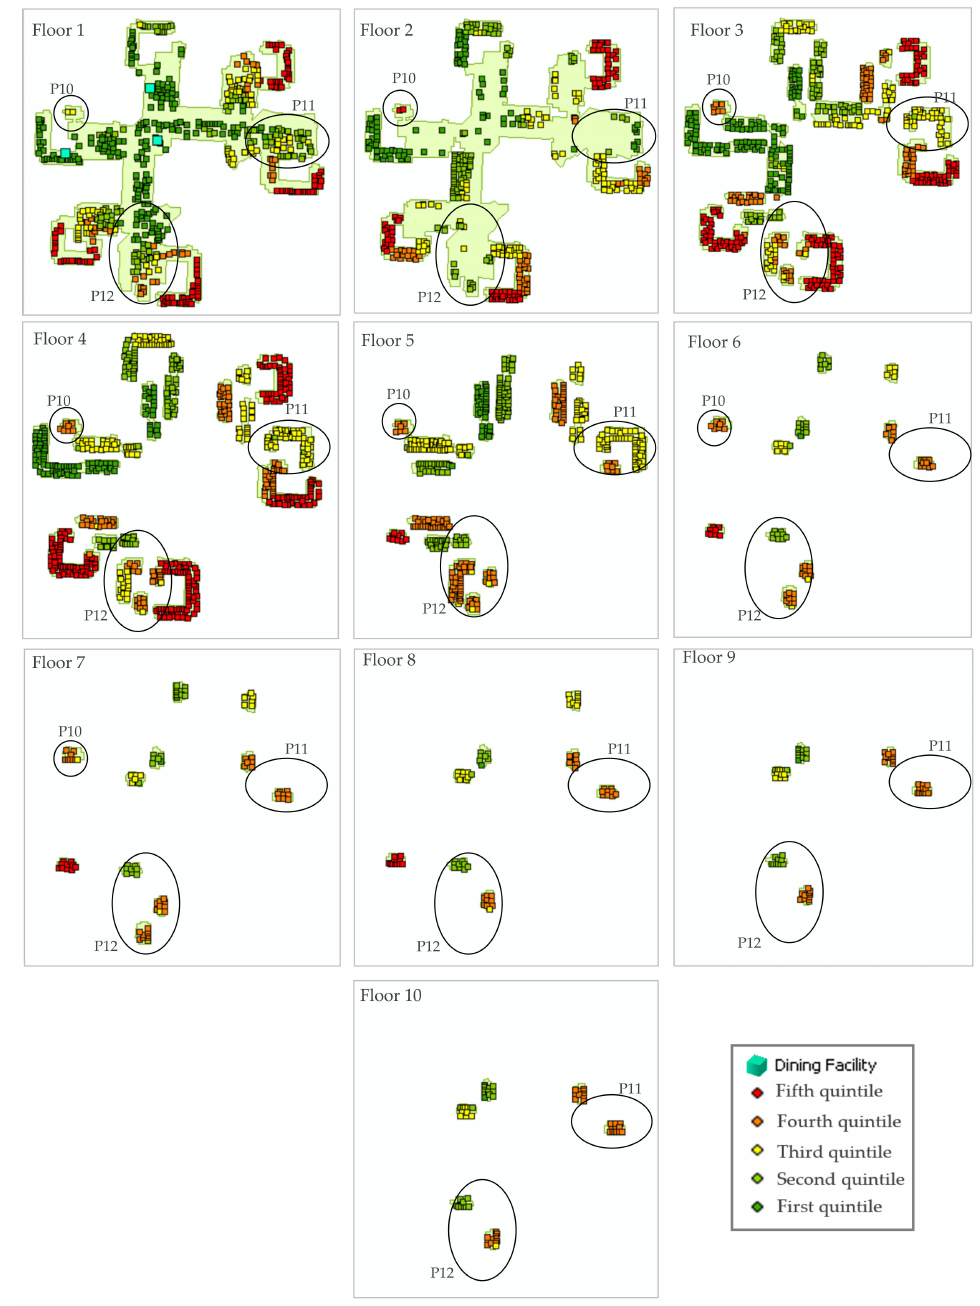
Figure A4. Syntactic accessibility to three facilities for different floors: classification in